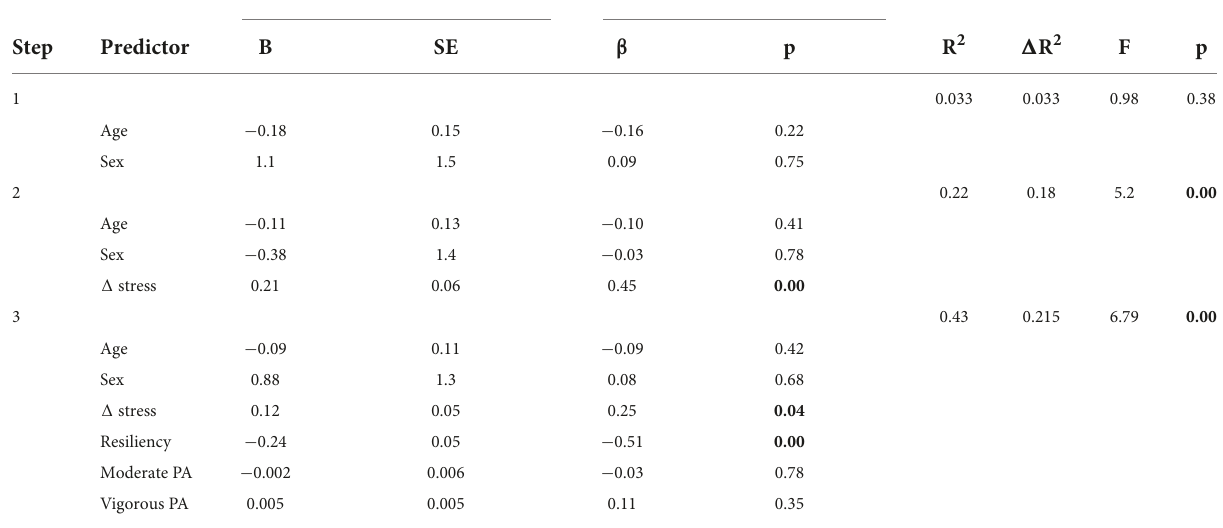
TABLE 5 Hierarchical regression coefficients: